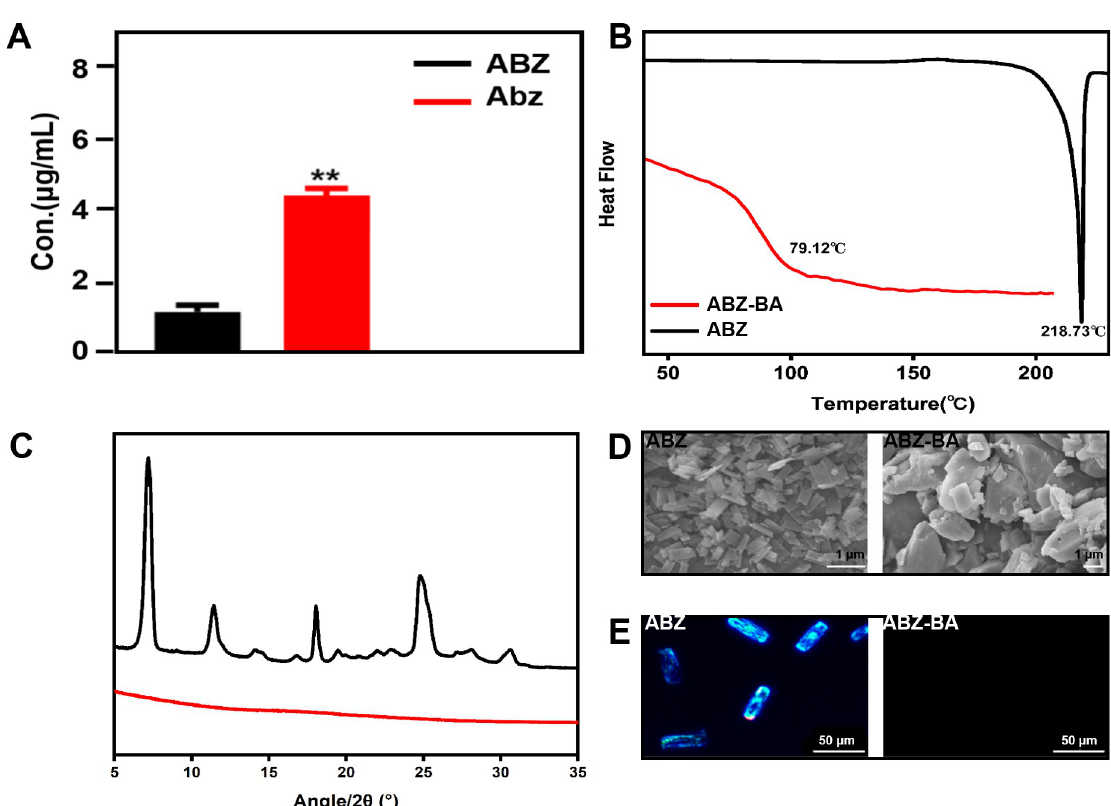
Fig 4. Study on the equilibrium solubility and solubilization mechanism of ABZ-BA. (A) Equilibrium solubility of Abz and ABZ (n = 3), where Abz represents ABZ in ABZ-BA, �� P < 0.001, compared with the ABZ group. (B—E) The thermal analysis characteristic spectra, wide-angle X-ray diffraction (WAXRD) spectra, scanning electron microscope (SEM) spectra, and polarizing microscope (POM) spectra of ABZ-BA and ABZ, respectively. SPSS 22.0 was used for statistical analysis. The measurement data of normal distribution was expressed by x ± s. Student’s t test was used for inter-group comparisons. P < 0.05 means the difference is statistically significant( �� p < 0.01).